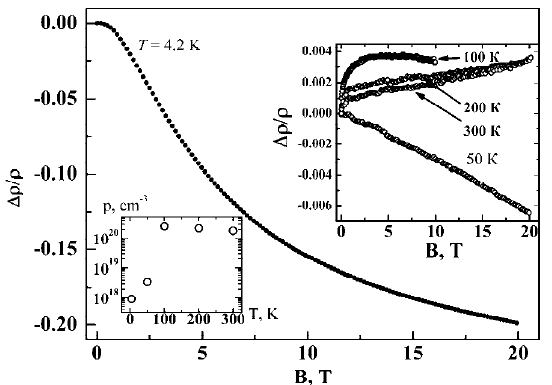
Fig. 4. A magnetic field dependence of the magnetoresistance for InSb-MnSb film at T = 4.2 K. Left inset: The plots of the hole concentration versus temperature. Right inset: Magnetoresistance as a function of magnetic field for different